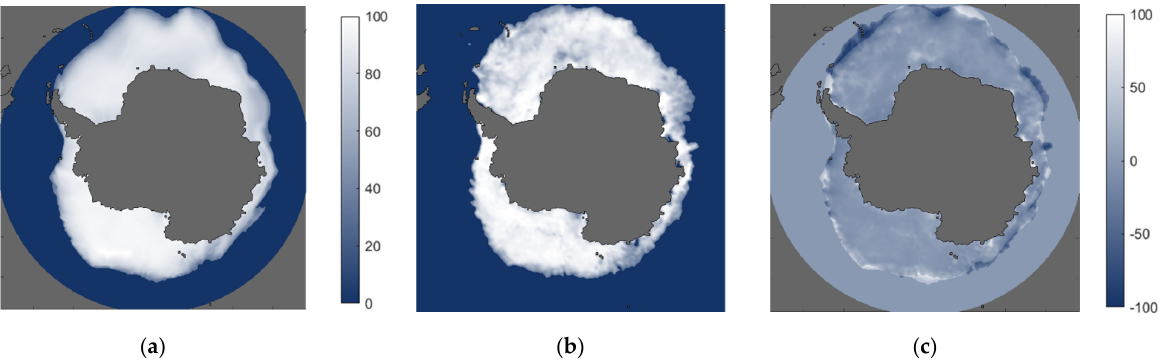
Figure 9. SIC (%) Arctic maps using MWR data from 13 November to 15 November. ( a ) FMPL-2 MWR map, ( b ) Ground truth map, ( c ) Error map.